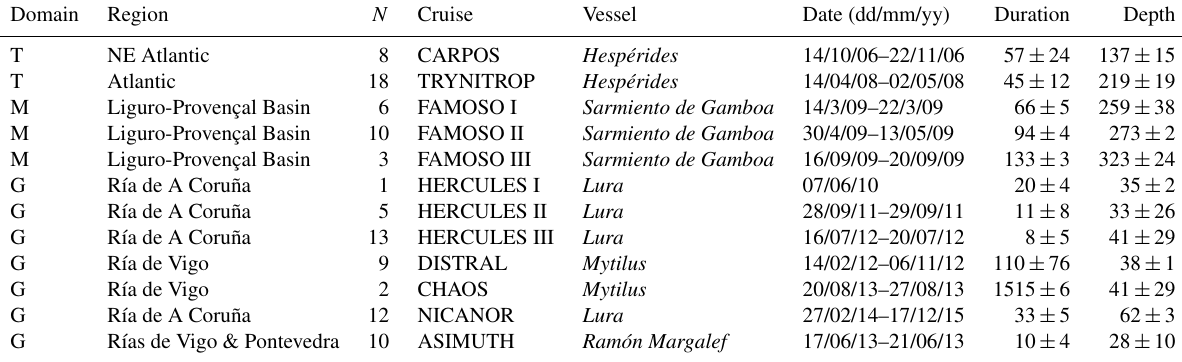
Table 1. Details of the data included in this study. Domain refers to the tropical and subtropical Atlantic Ocean (T), the Mediterranean Sea (M), and the Galician coastal upwelling (G). N indicates the number of stations sampled during each cruise. Duration (mean ± standard deviation, in minutes) is the time used for the turbulence profiler deployment in each station. Depth (mean ± standard deviation, in meters) is the maximum depth reached by the microstructure